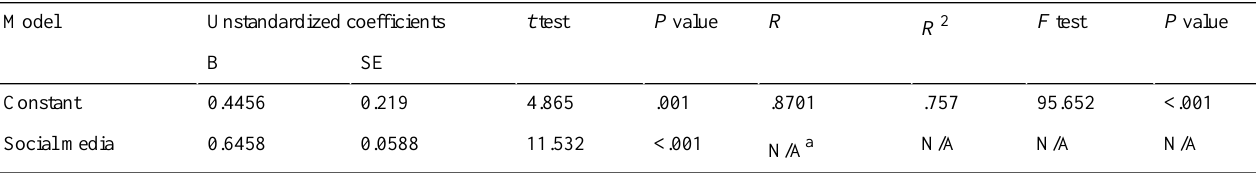
Table 11. Simple regression model analysis of a dependent variable (spreading panic about coronavirus disease) on the effects of social media on spreading panic about coronavirus disease and social media’s impact on mental health in the Kurdistan Region of